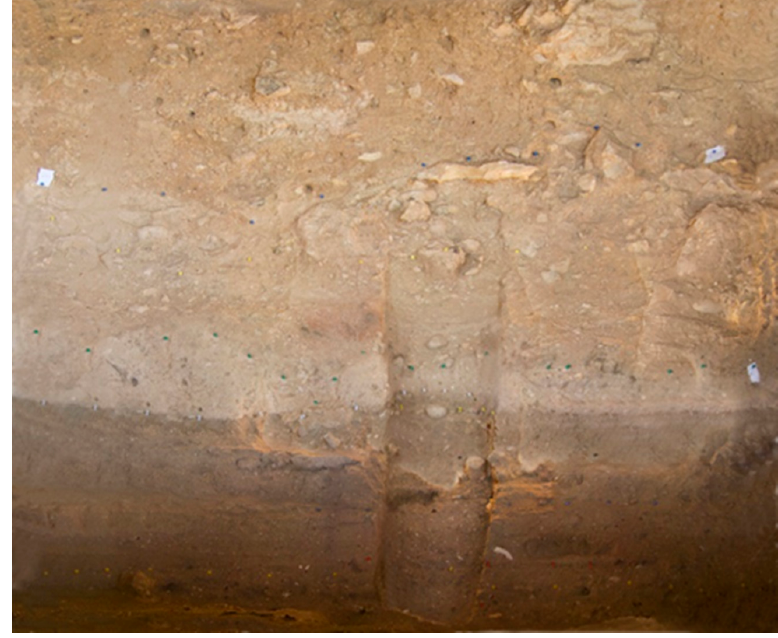
Figure 2. Stratigraphic sample inside the rock shelter.